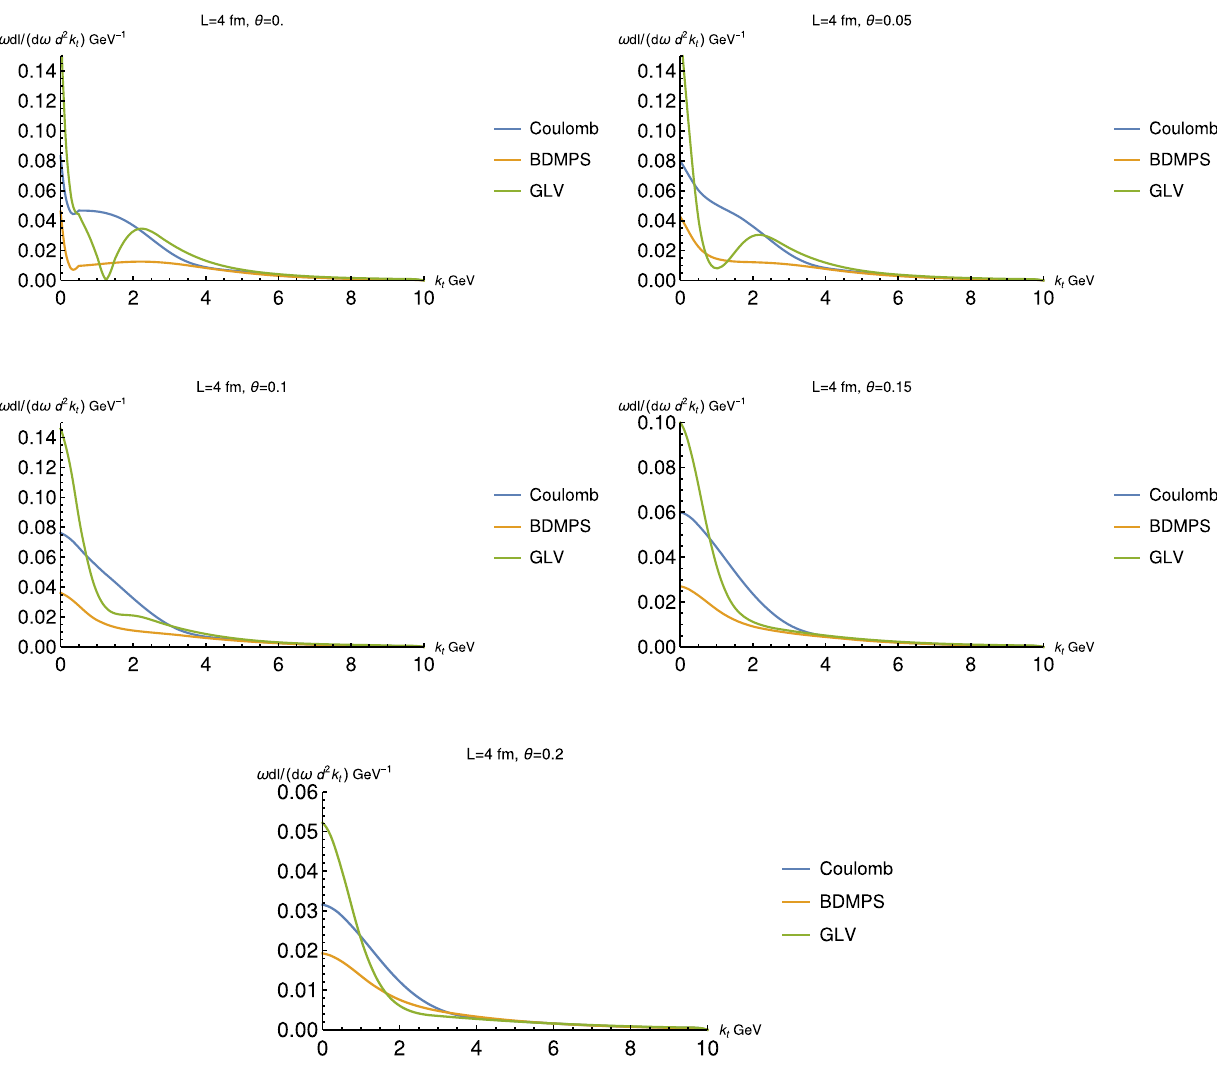
Fig. 2 The angular distribution of the radiated gluons for ω = 10 GeV for different θ = 0 , 0 . 05 , 0 . 1 , 0 . 15 , 0 . 2